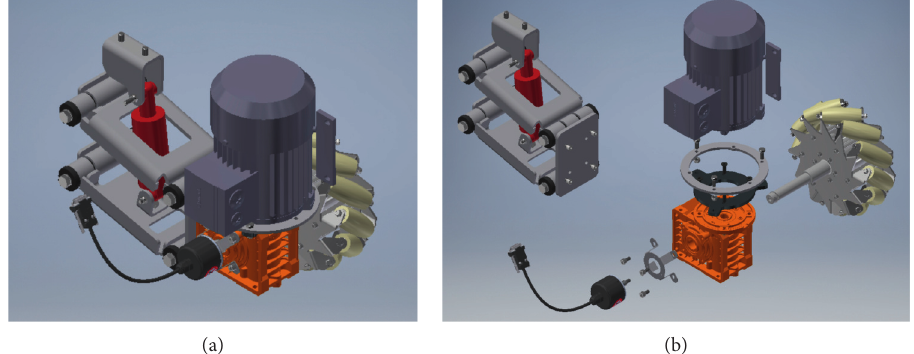
Figure 9: (a) Isometric and (b) exploded view of the suspension system including the three-phase motor, mecanum wheel, and encoder